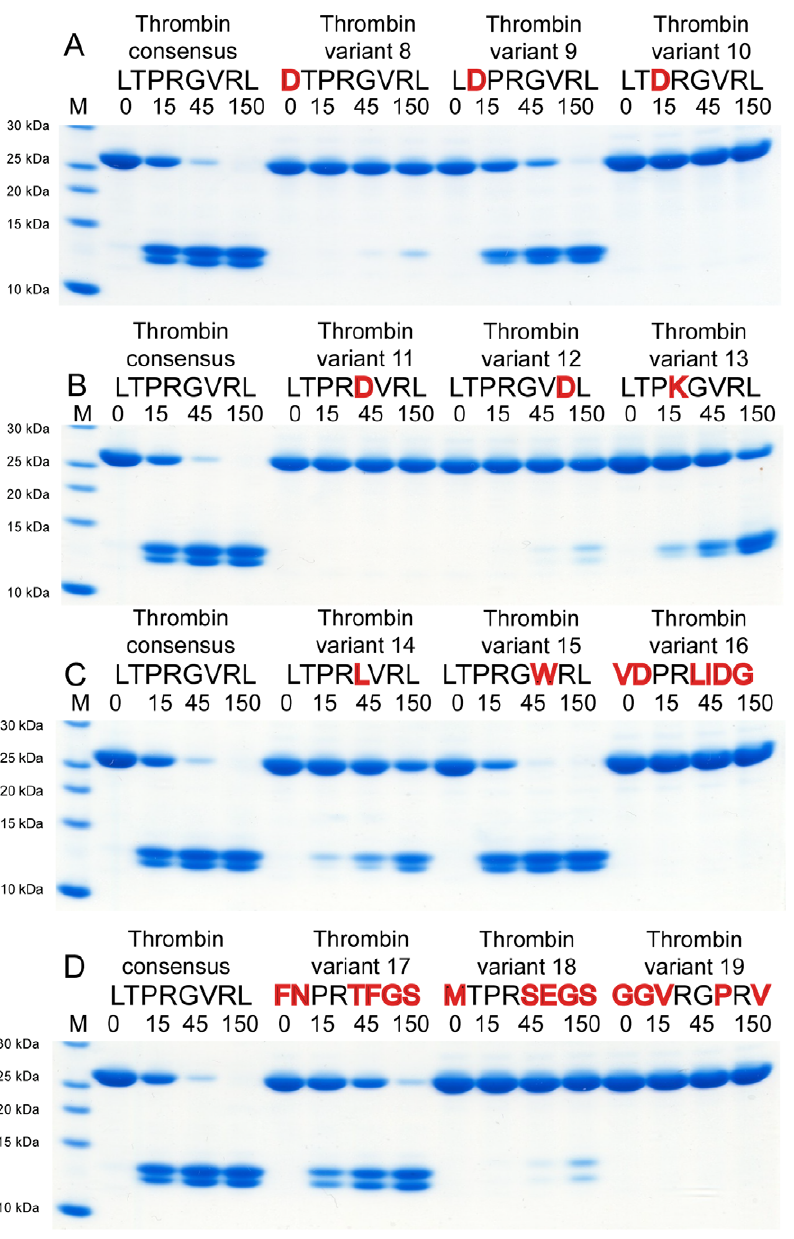
Figure 4. Analysis of the cleavage specificity by the use of new types of recombinant protein substrate. Panels A to D shows the cleavage of a number of substrates by thrombin, where individual amino acids has been changed from the thrombin consensus sequence. The name and sequence of the different substrates are indicated above the pictures of the gels. The time of cleavage (in minutes) is also indicated above the corresponding lanes of the different gels. Variants 16 is the Protein C cleavage site R211, variant 17 is the Prothrombin site R327, variant 18 is the Prothrombin site R200 and variant 19 is the Fibrinogen A alpha site R35 (see Figure 1).